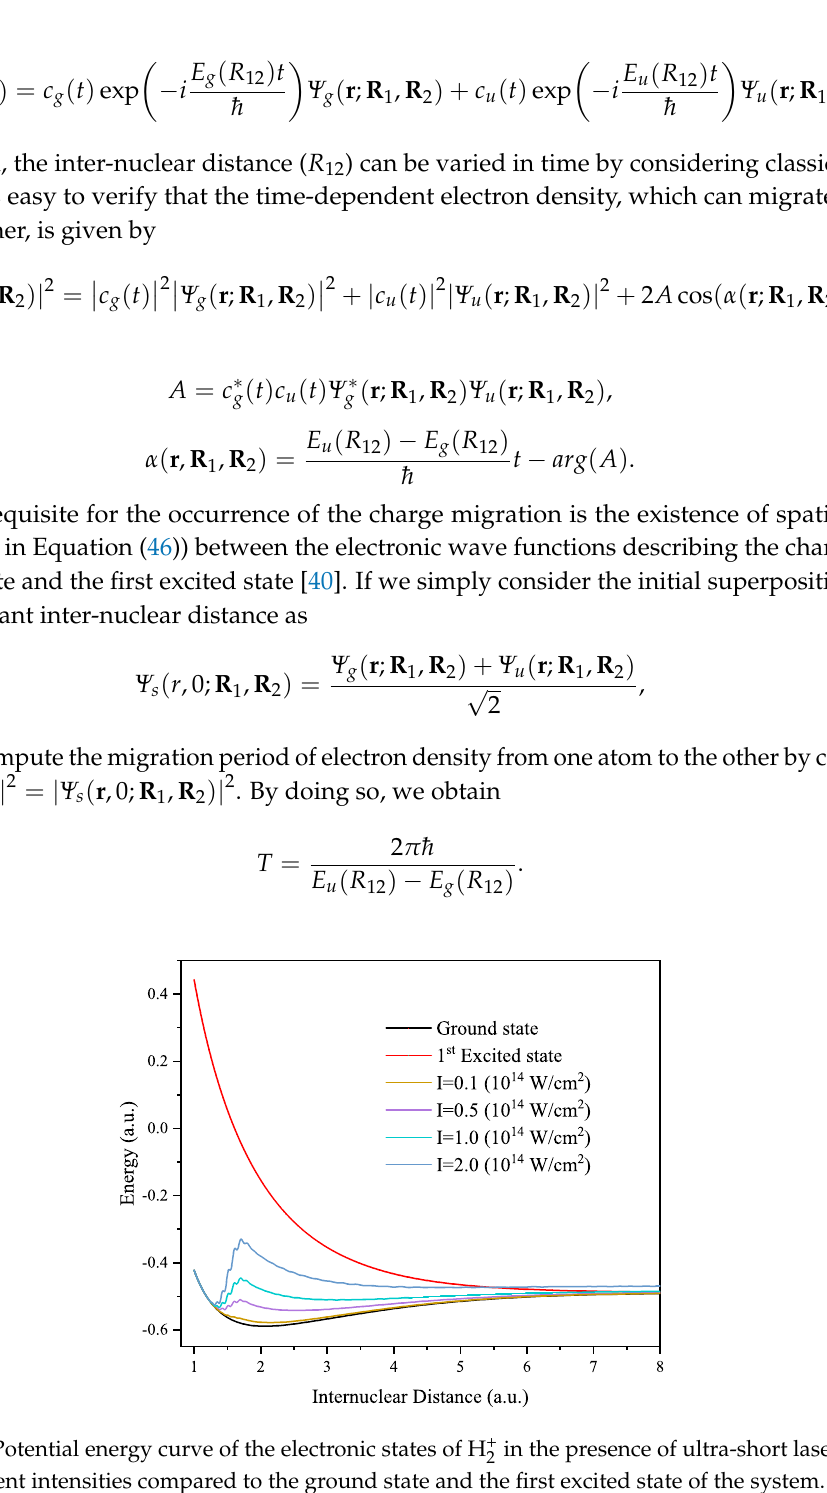
in the presence of ultra-short laser field 2